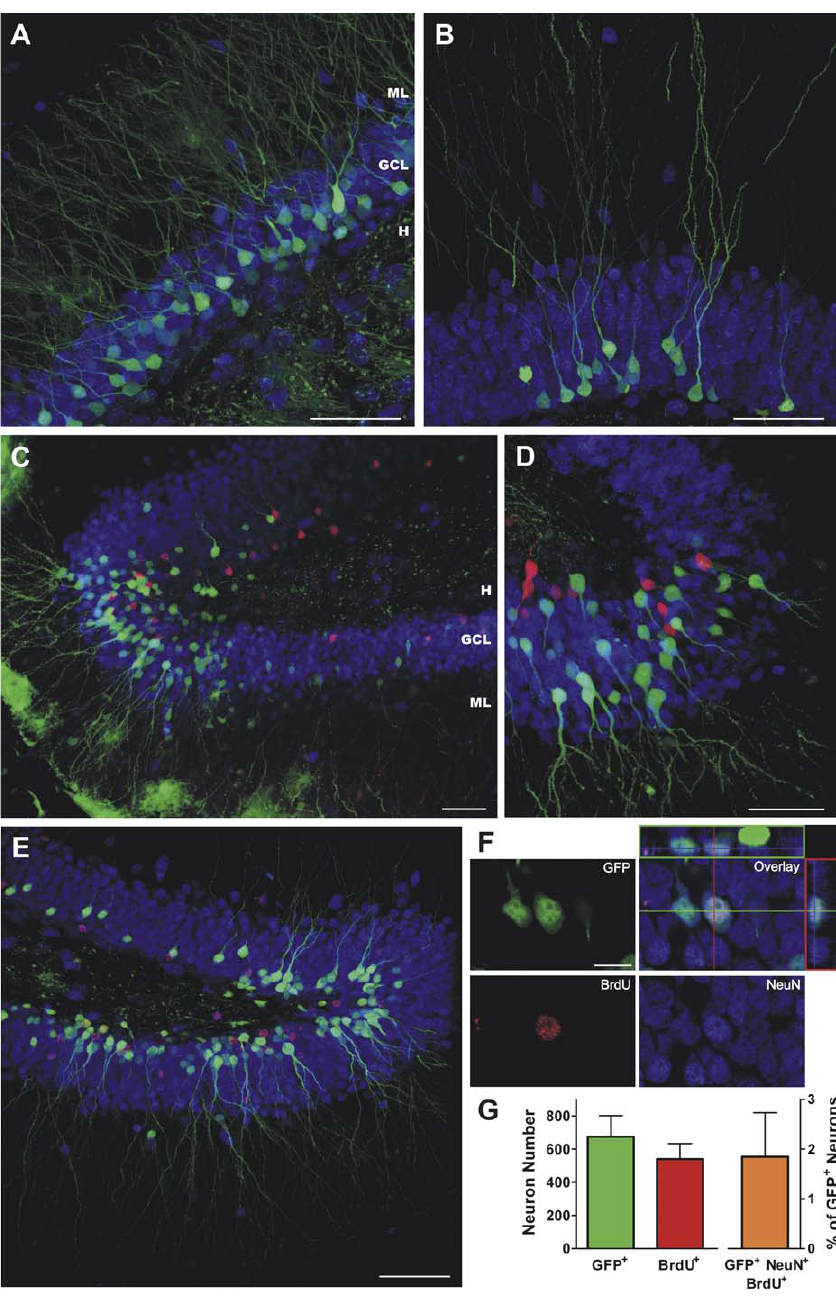
Figure 1. Fluorescent Labeling of DGCs Born during Early Postnatal and Adult Neurogenesis (A) and (B) Retroviral delivery of GFP into DGCs generated at P7 (A) and P42 (B), analyzed 7 wk after each injection. The GCL was labeled by immunohistochemistry for the neuronal marker NeuN (blue). Images are merges of 27 (A) and 21 (B) confocal planes taken from coronal sections (40- l m thick). H, hilus; ML, molecular layer. (C) and (D) Double retroviral labeling of DGCs generated at P7 (GFP þ , green) and P42 (RFP þ , red). Images are merges of nine (C) and 20 (D) confocal planes taken from fixed transverse sections of the DG (400- l m thick) from 13-wk-old mice. (E) Double labeling of DGCs with GFP (green) and BrdU (red): intrahippocampal injections of CAG-GFP retrovirus in P7 were followed by daily injections of BrdU carried out from P21 to P25; brains were analyzed at P53. The image is a merge of 16 confocal planes. (F) Example of a sporadic event of co-localization of GFP, BrdU, and NeuN shown by a single optical section for the green, red, and blue channels. Their overlay is shown together with the orthogonal projections onto the x-z (top) and y-z (right) planes. (G) Number of GFP þ or BrdU þ cells per mouse (left) and the percentage of GFP þ cells showing BrdU label (right). Data are mean 6 standard error of the mean (SEM) ( n ¼ 3 mice). Scale bars indicate 50 l m (A–E) or 10 l m (F). DOI: 10.1371/journal.pbio.0040409.g001